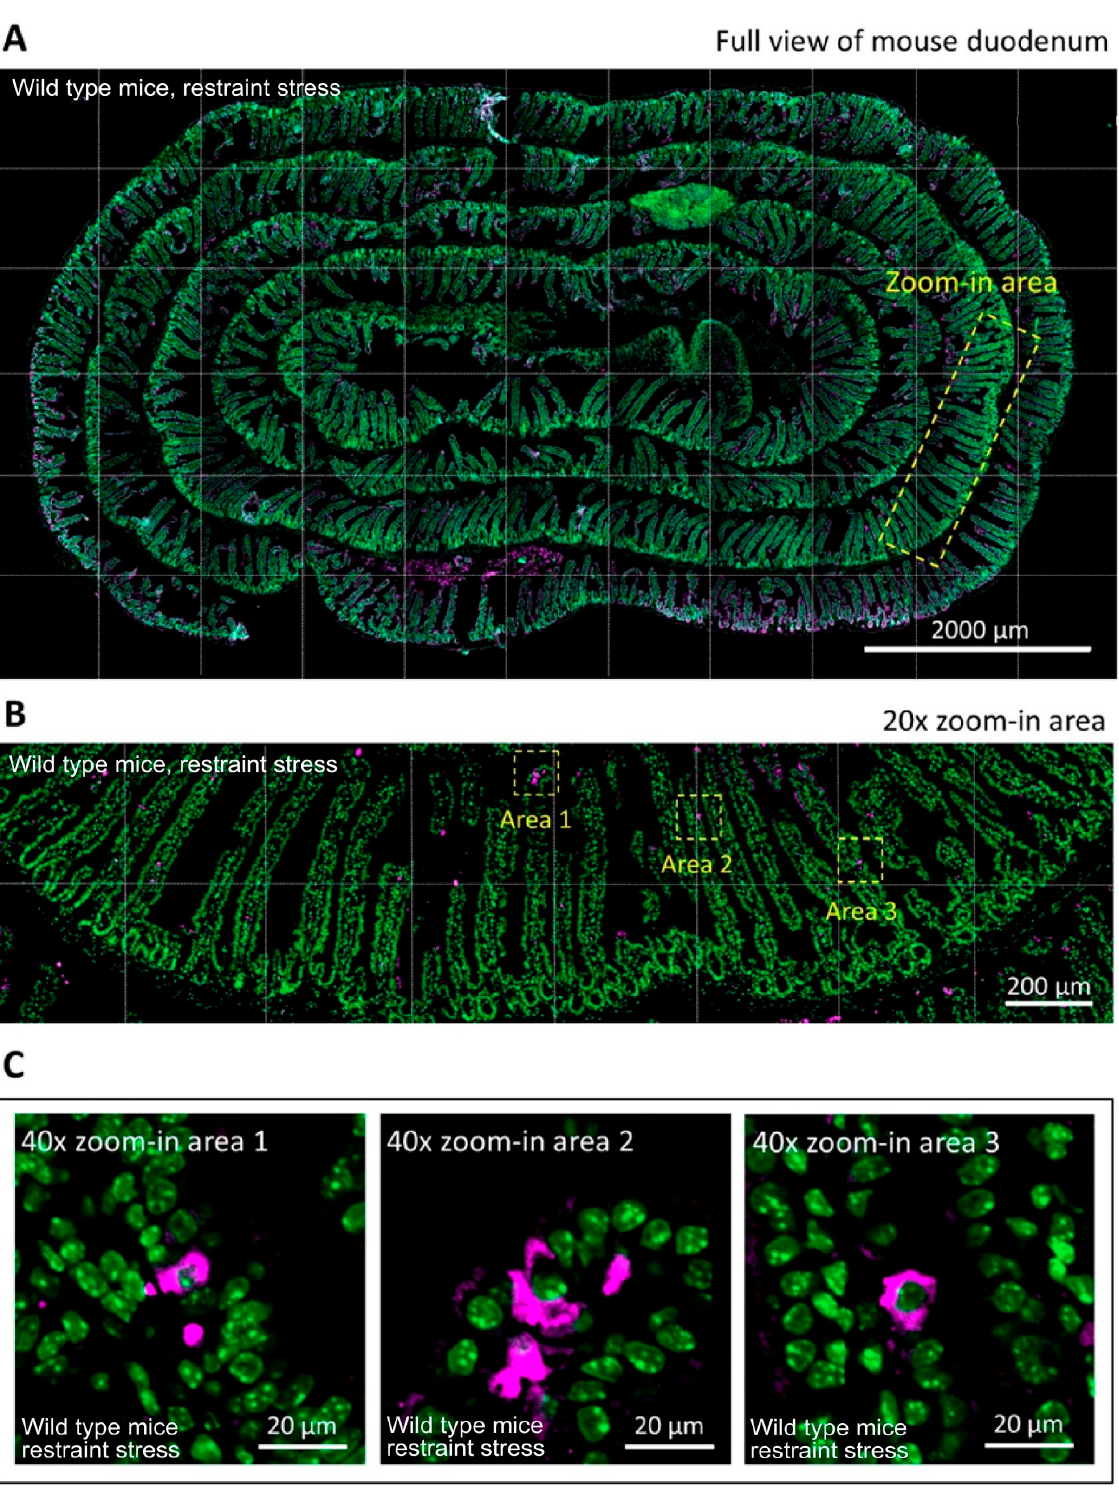
Figure 9. Confocal microscopy of IHC activated-form caspase 3 staining. A tissue section IHC of a Swiss-rolled duodenal sample was stained with a fluorescence-labeled anti-activated-form caspase 3 antibody. ( A ) A representative image at low magnification is presented. ( B ) The yellow boxed zoomed-in area in ( A ) is enlarged as a higher magnification view. ( C ) Areas 1, 2, and 3 in ( B ) are further enlarged to observe the detailed expression patterns of activated-form caspase 3 in the villi of duodenal tissue. Scale bars: 2000 μ m ( A ), 200 μ m ( B ), and 20 μ m ( C ).